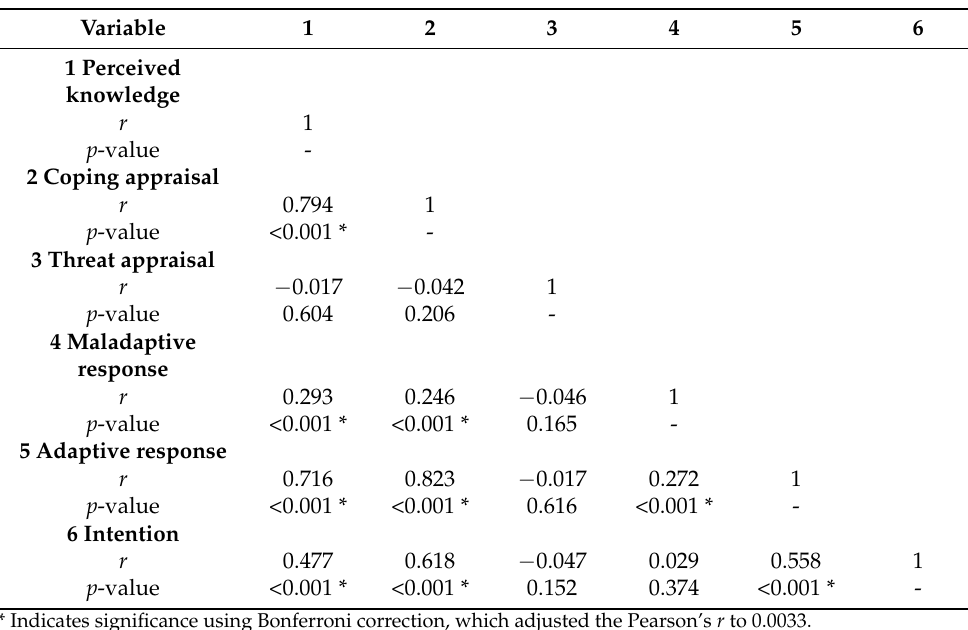
Table 3. Correlations between study variables.